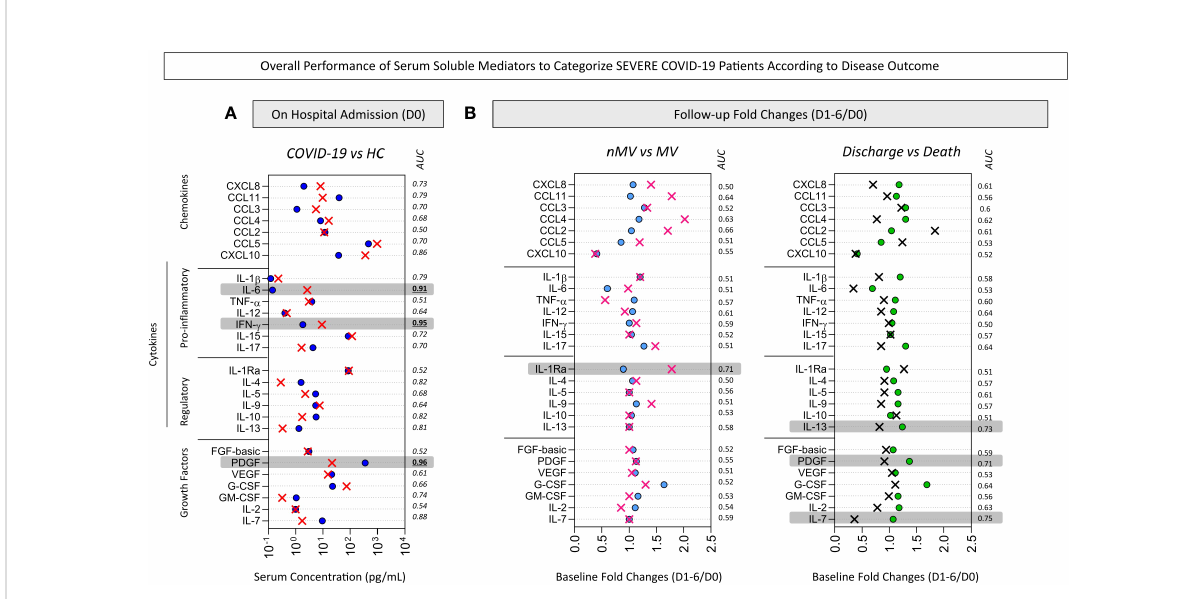
FIGURE 6 Overall performance of serum soluble mediators to categorize severe COVID-19 patients according to disease outcome. The performance of serum chemokines (CXCL8, CCL11, CCL3, CCL4, CCL2, CCL5, CXCL10), pro-in fl ammatory cytokines (IL-1 b , IL-6, TNF- a , IL-12, IFN- g , IL-15, IL - 17), regulatory cytokines (IL-1Ra, IL-4, IL-5, IL-9, IL-10, IL-13) and growth factors (FGF-basic, PDGF, VEGF, G-CSF, GM- CSF, IL-2, IL-7) to categorize patients with COVID-19 were assessed to identify putative immunological parameters for complementary diagnosis and